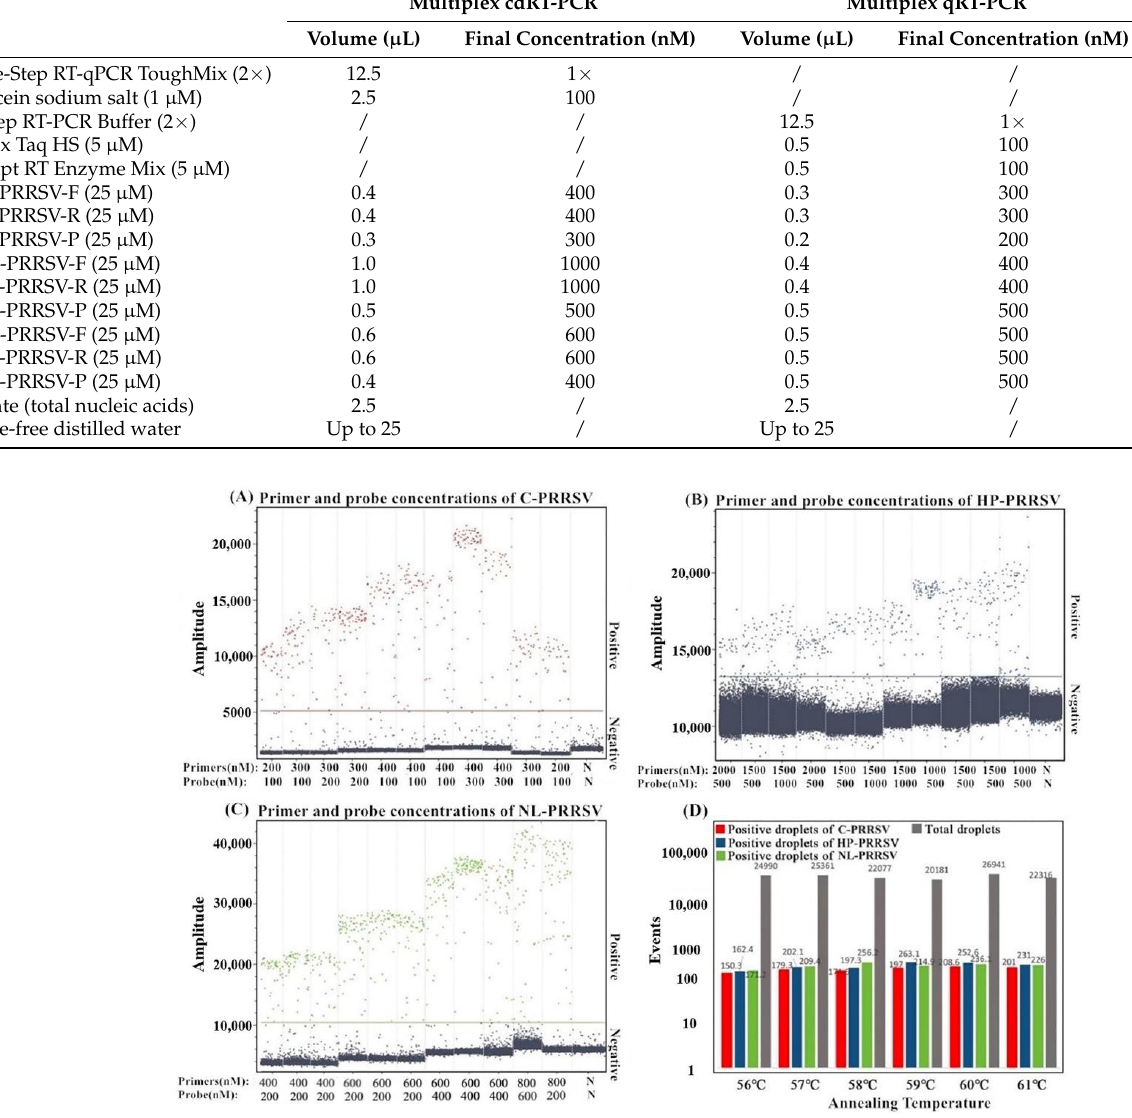
Figure 1. Optimization of the primer and probe concentrations ( A – C ) and the annealing temperature ( D ) for the multiplex cdPCR. ( A – C ) show the amplification results of p-C-PRRSV, p-HP-PRRSV, and p-NL-PRRSV plasmids (all at final concentrations of 3.20 × 10 2 copies/ µ L) with different probe and primer concentrations. N: negative control. ( D ) shows the amplification results of p-C-PRRSV, p-HP-PRRSV, and p-NL-PRRSV plasmids (all at final concentrations of 3.20 × 10 2 copies/ µ L) with different annealing